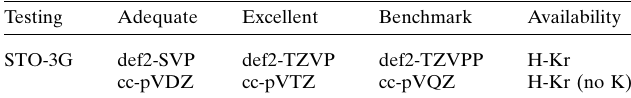
Table 1 Basis sets available in the program HARt .